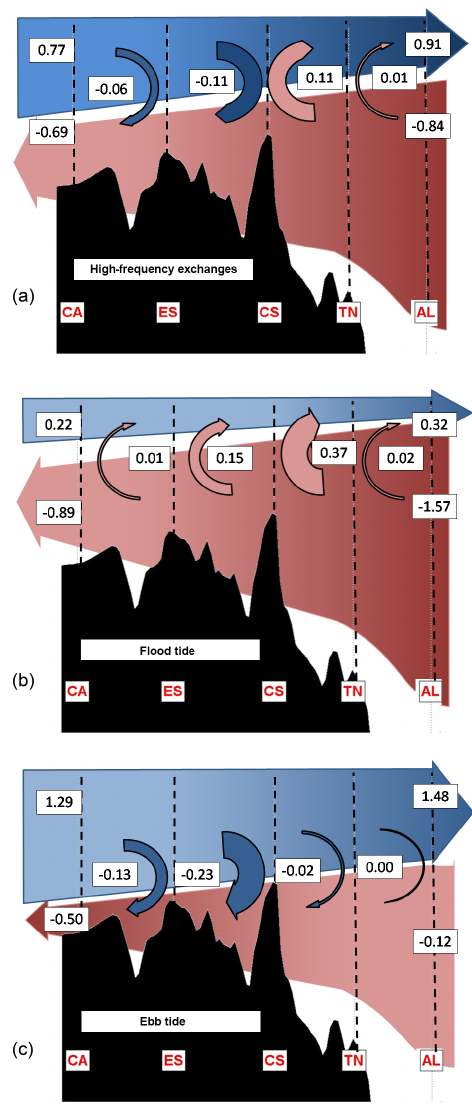
Figure 7. Two-layer diagram to explain tidal transport divergence in each layer at high frequency. (a) Illustration of the mean exchange at high frequency. (b) The exchanges during the flood tide (barotropic tidal current towards the Atlantic Ocean). (c) The same for the ebb tide (tidal current towards the